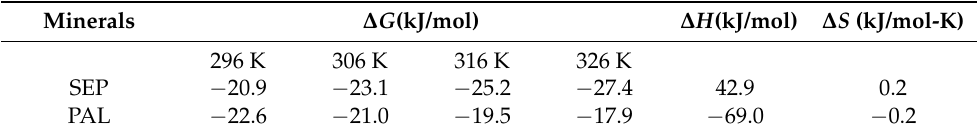
Table 1. Thermodynamics of TB sorption on PAL and SEP.